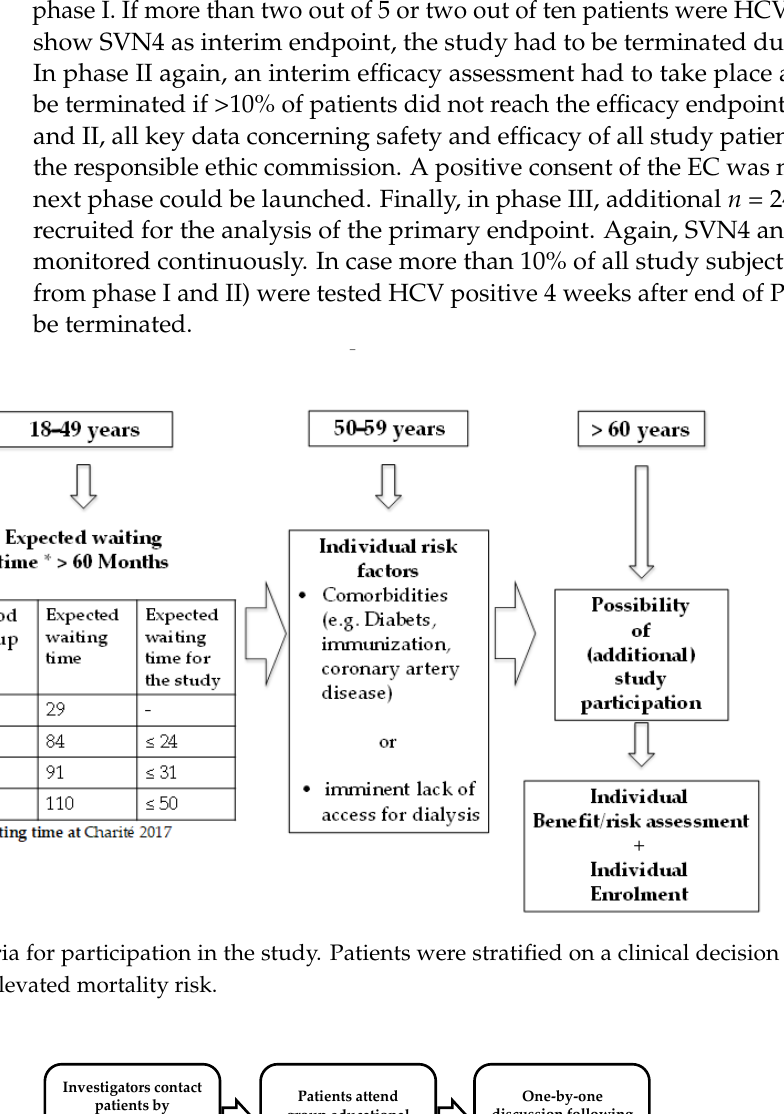
Figure 3: Staggered study design . The flowchart reflects the stepwise cautious enroll- ment of n = 5 patients in phase I, n = 10 in phase II, and an additional n = 24 in phase III. Within each phase, a prespecified efficacy interim analysis SVN4 (sustained virus neg- ativity 4 weeks after therapy) was performed in each phase of the study. In phase I, study would be terminated if more than 2 out 5 or 2 out of 10 patients tested positive for HCV transmission. In all other phases, study termination was defined by a HCV transmission rate >10% in interim efficacy analysis. RTx = renal transplantation.